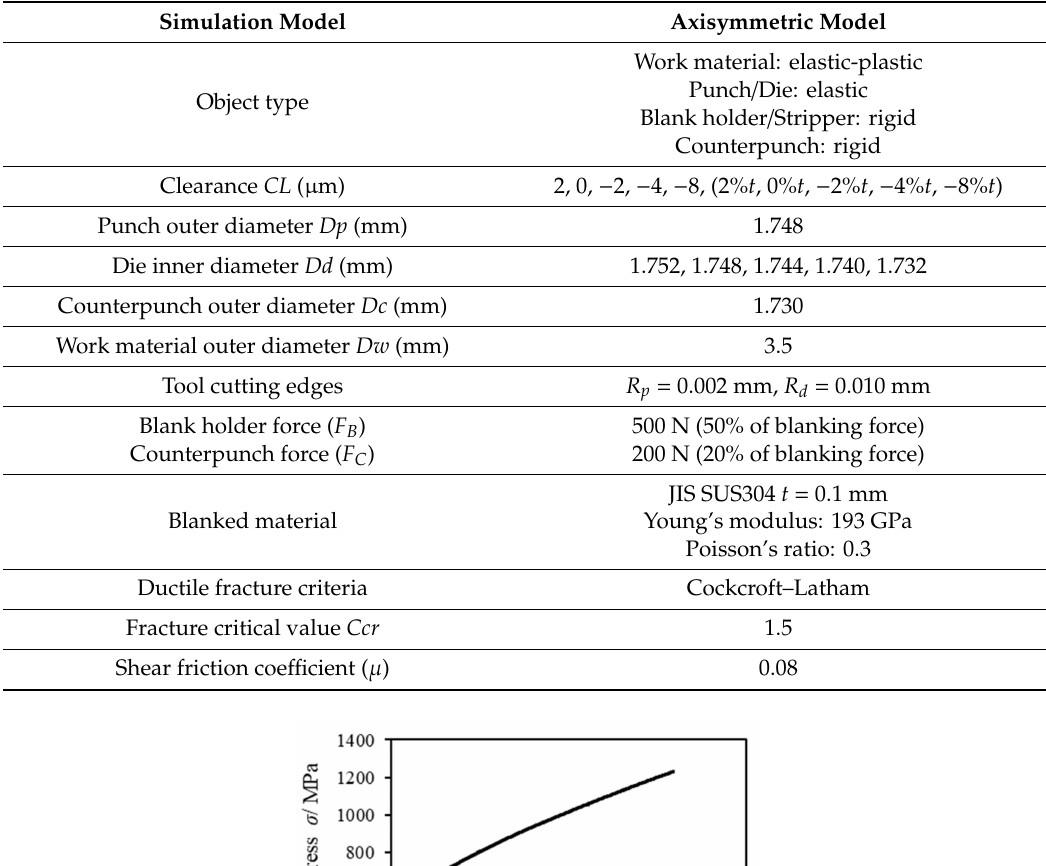
Figure 2. Finite Element Method simulation model (axisymmetric model). Table 4. FEM simulation condition.